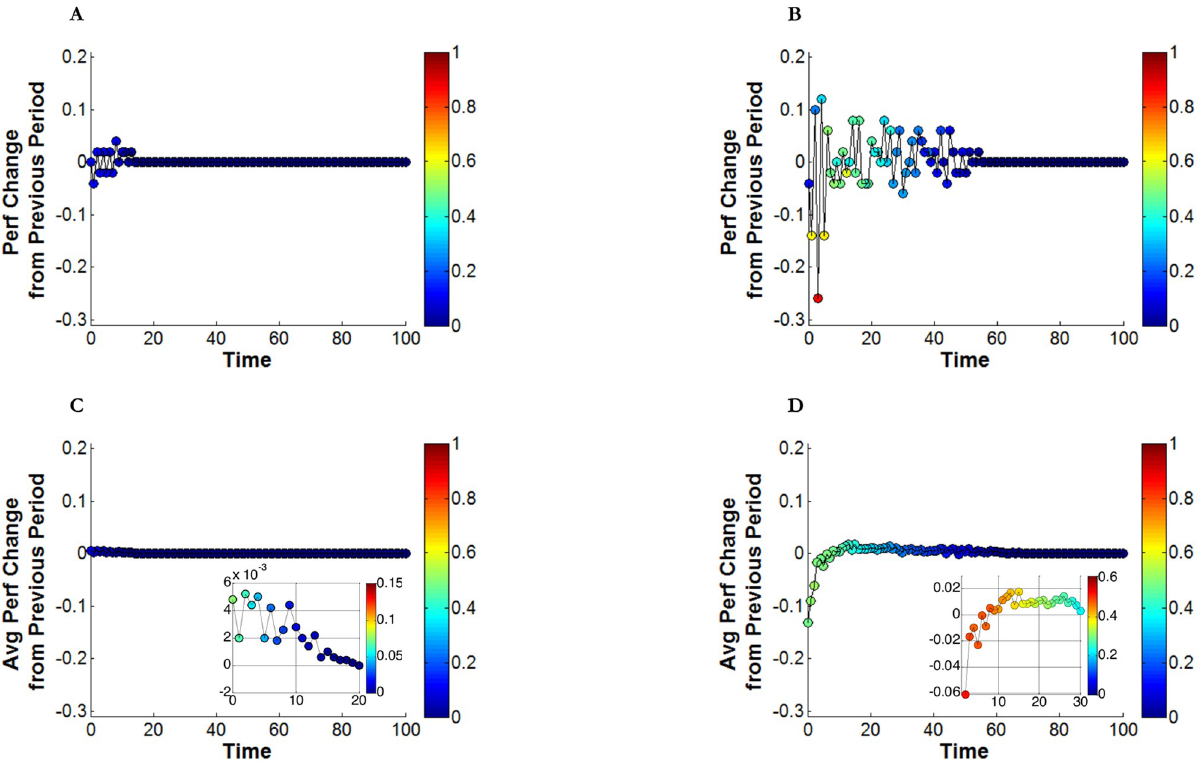
Fig 3. Search restriction and intertemporal variation in performance. Colors in data plot and color bars represent Hamming distance between the source and the learning target. (A) σ = 0.3 for a single Individual (B) σ = 1.0 for a single Individual (C) σ = 0.3 for average of 100 individuals (D) σ = 1.0 for average of 100